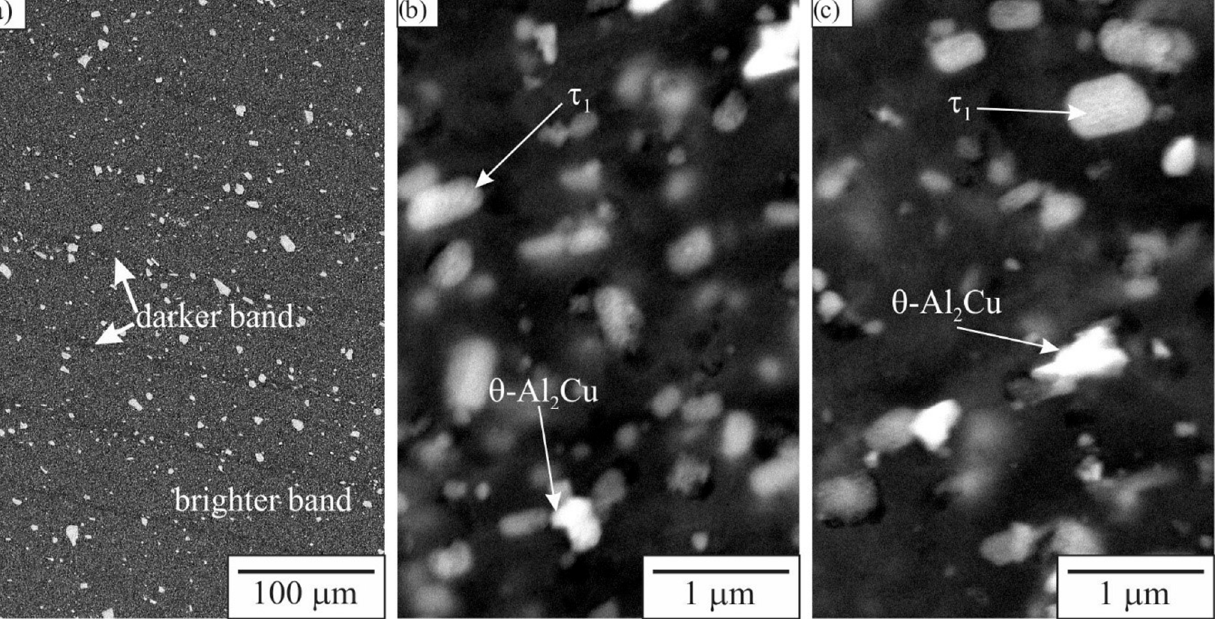
Figure 8. Bright-field transmission electron micrographs of sample FSP950. ( a ) stir zone, region NZ in Figure 2, ( b ) within the stir zone in region T-AS.